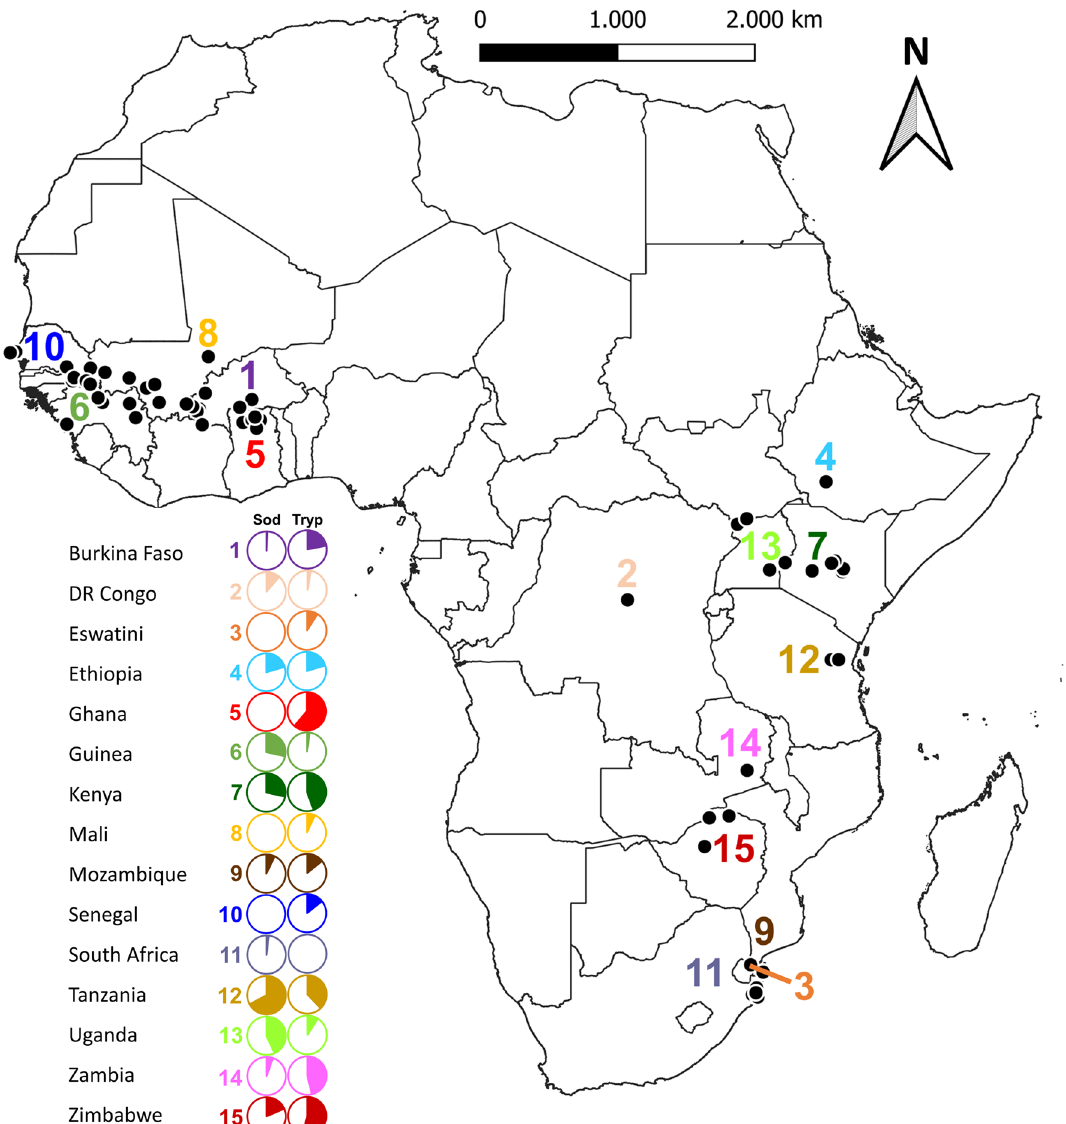
Figure 1. The geographical locations of tsetse samples in Africa. Circles indicate the total prevalence of Sodalis and Trypanosoma per country. Black dots indicate samples collection site(s) per